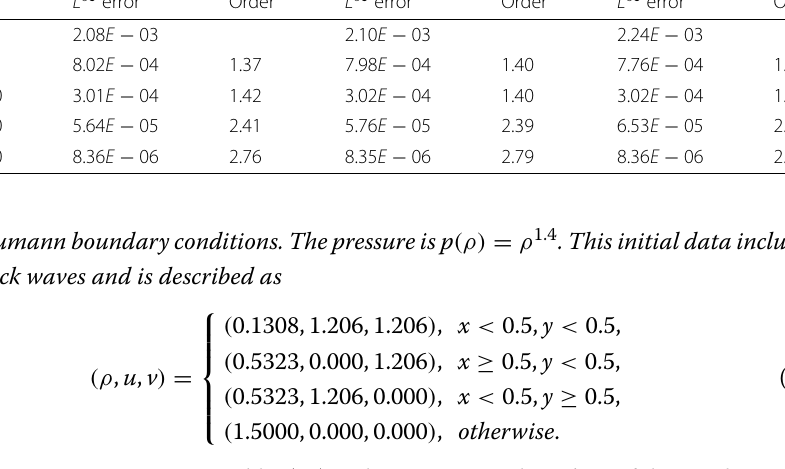
Table 7 Example 4. L ∞ errors and numerical orders of temporal accuracy obtained with the GSA IMEX-ARS3 WCNS at t = 0.02 ε = 0.01 M × N